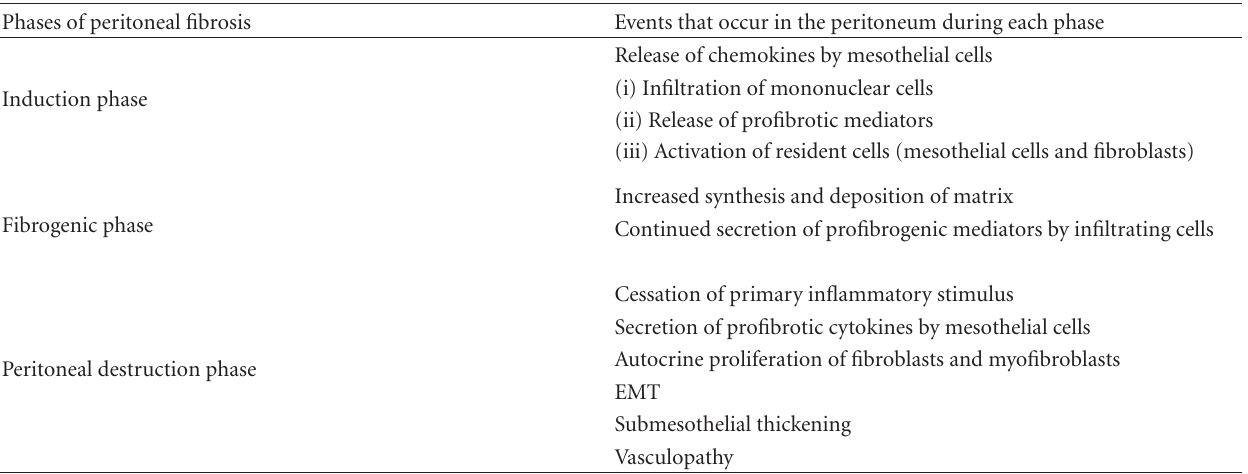
Table 1: Induction of peritoneal